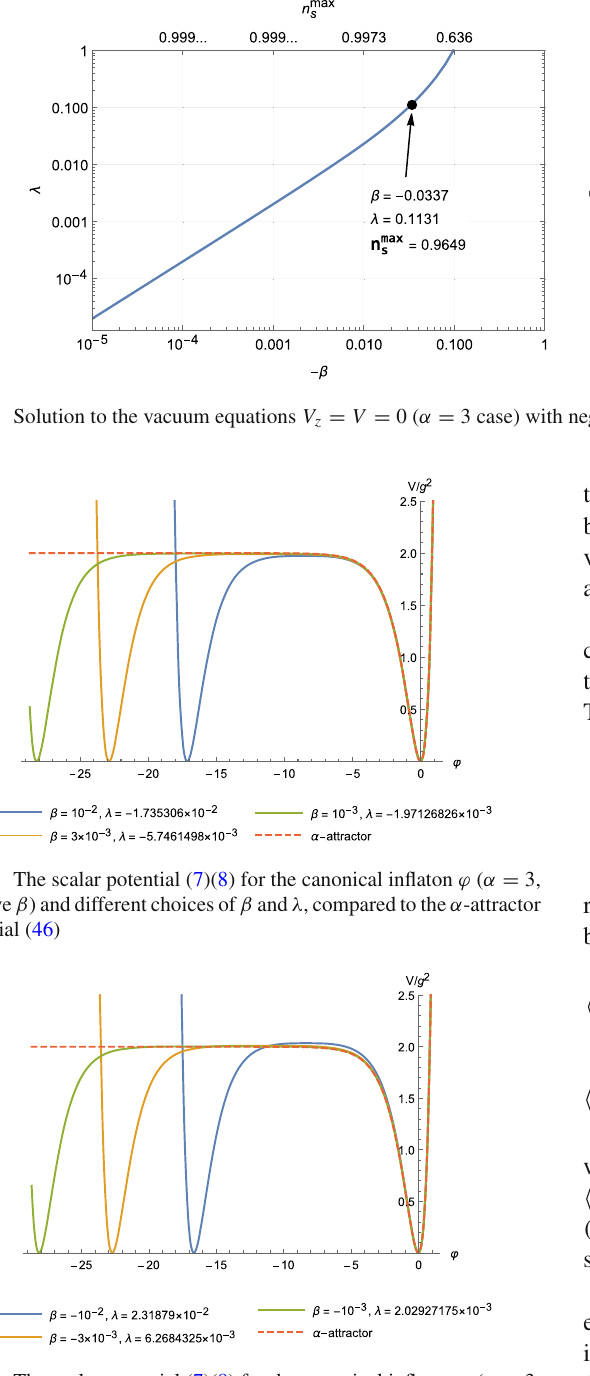
Fig. 9 The scalar potential (7)(8) for the canonical inflaton ϕ ( α = 3, negative β )anddifferentchoicesof β and λ ,comparedtothe α -attractor potential